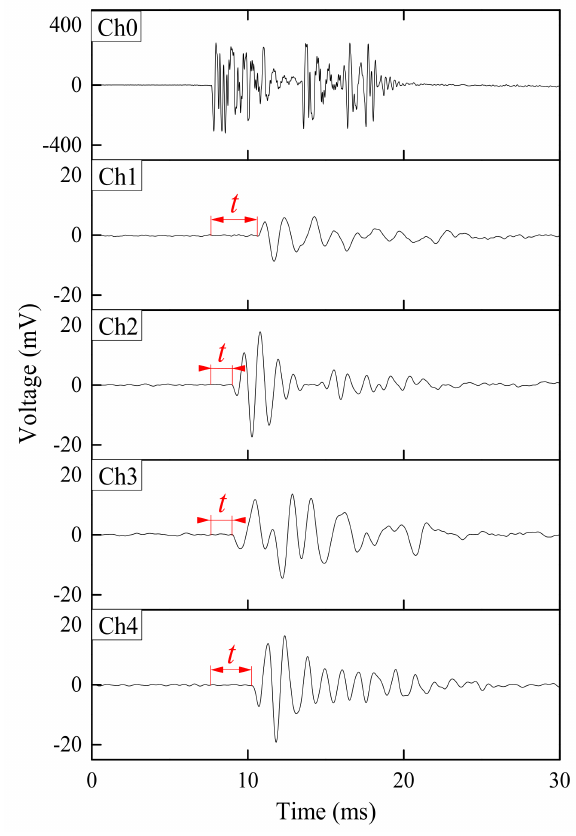
Figure 4. Example of transmitted and received signals obtained from small-scale model